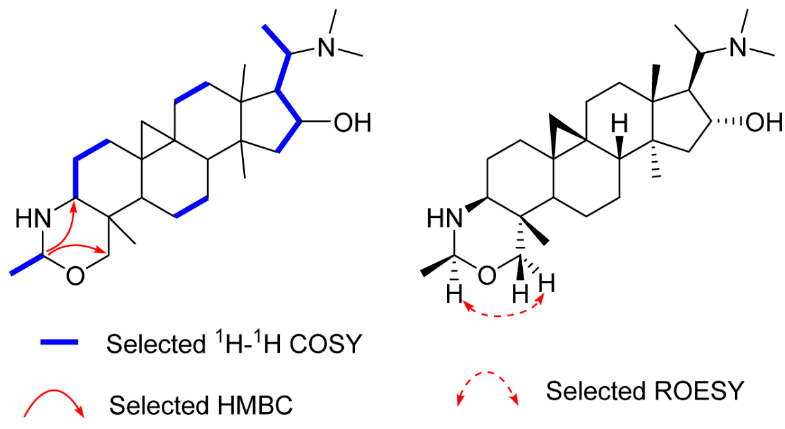
Figure 2. Key 2D correlations of 1 . Table 1. 1 H-NMR and 13 C-NMR data of compounds 1 – 3 a .